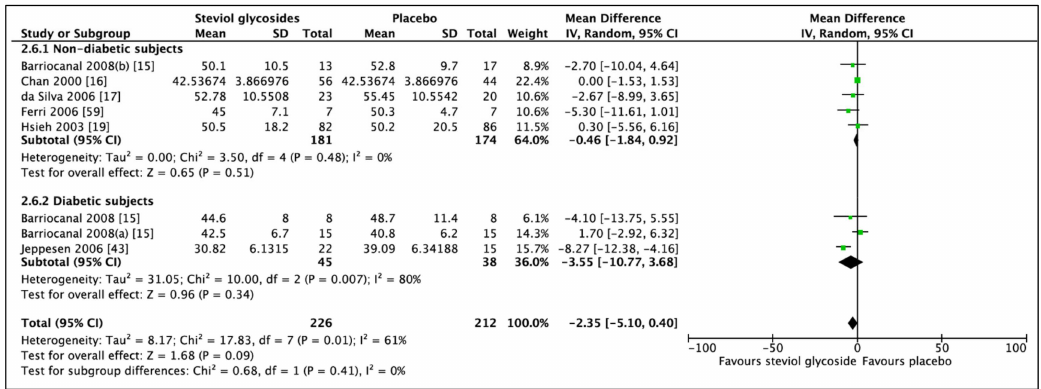
Figure 10. E ff ect of SGs on high-density lipoprotein cholesterol (HDL-C, mg / dL) CI: confidence interval; MD: mean di ff erence; RCTs: randomized controlled trials; SD: standard